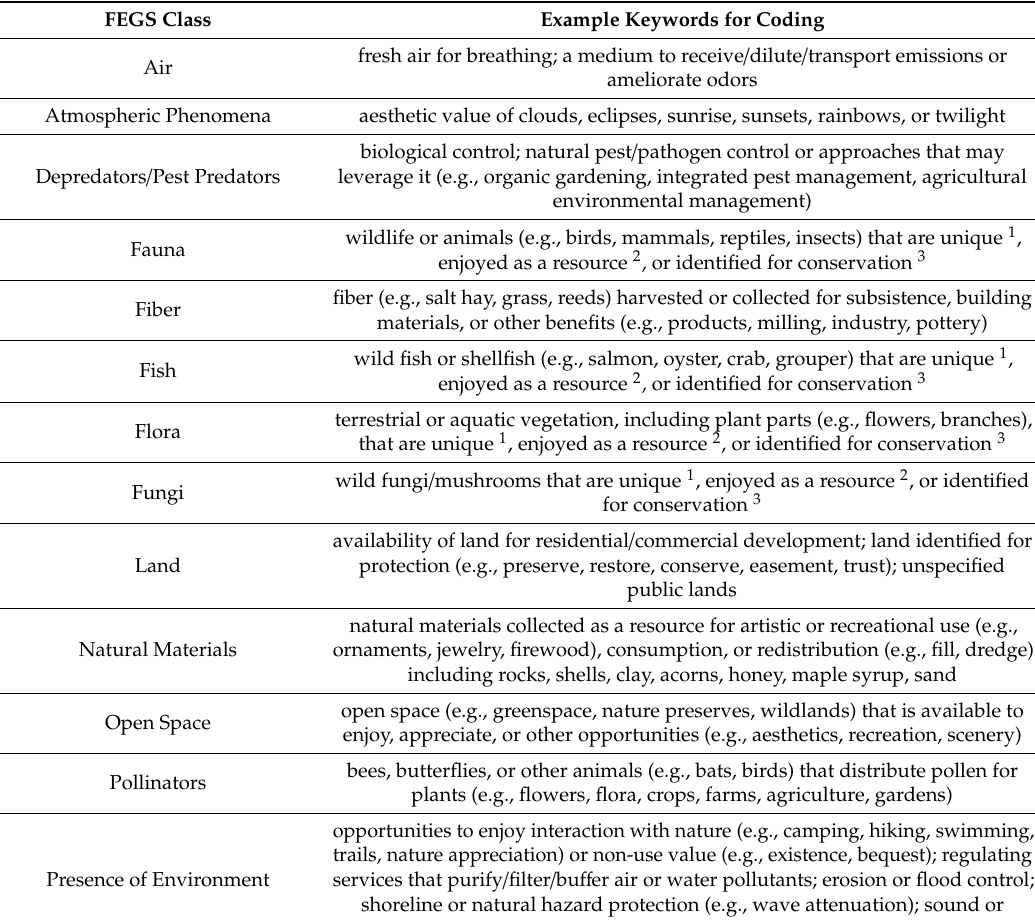
Table 5. Definitions used to code each category of FEGS and develop keywords (full list in Supplementary Table